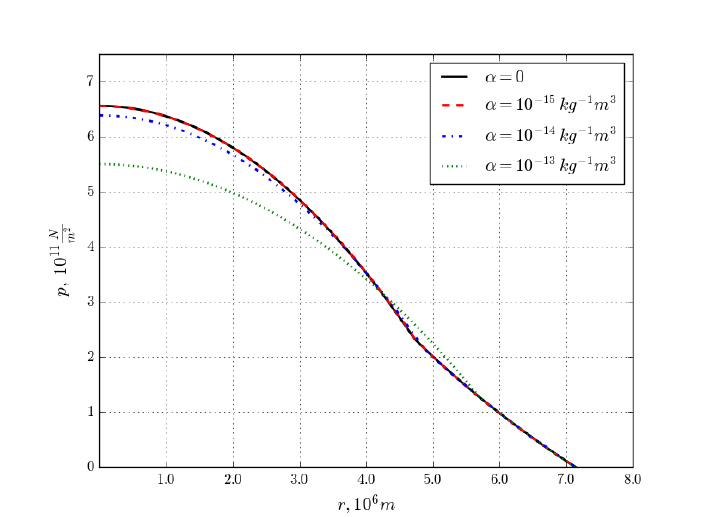
Figure 2. Relation between pressure and radius for Kepler-78 b exoplanet calculated analytically using the formulas derived in this work. The curves are plotted for four different values of the parameter α = c 2 κ 2 β . The planet is assumed to be composed of two layers.